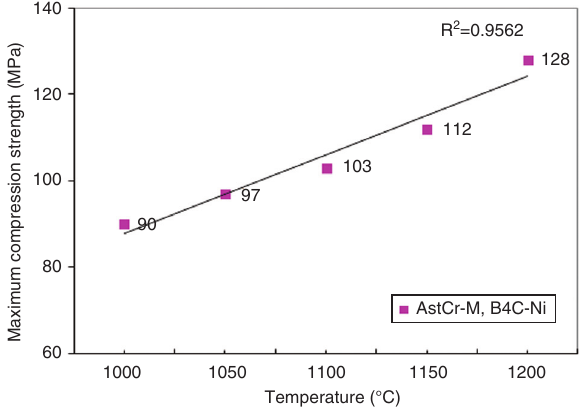
Figure 6 Compression strength results from samples sintered at different